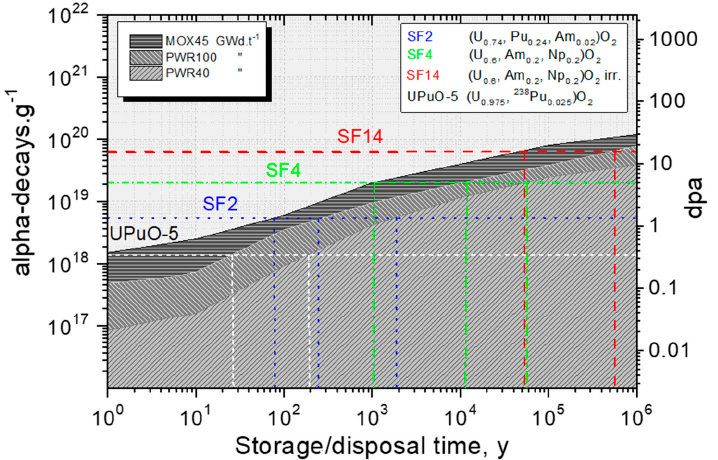
Figure 2. Evolution of the alpha dose and damage (expressed as dpa) in three types of fuels: PWR fuel with 40 GWd.t ‐ 1 , high burnup PWR fuel with 100 GWd.t ‐ 1HM , and MOX with 45 GWd.t ‐ 1 . The